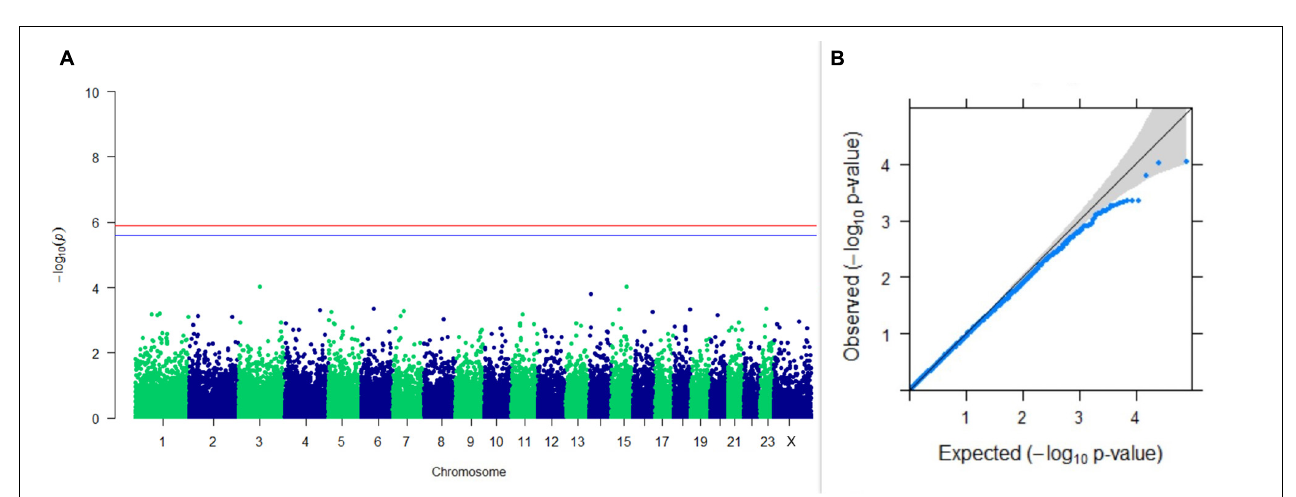
FIGURE 4 | Results of GWAS for PC2 of the test day’s fat percentage. (A) Manhattan plot of genome-wide SNPs. The red line indicates the p- value threshold (expressed as –log 10 P ) corresponding to FDR-corrected p- values or q = 0.05, above which the SNPs are considered to be significantly associated with the trait, while the blue line indicates the genome-wide suggestive threshold at q = 0.1. The SNPs identified on chromosome no. 24 were screened out from analysis because of stringent quality control; hence, it is not represented in the Manhattan plot. (B) Q-Q plot of the p-